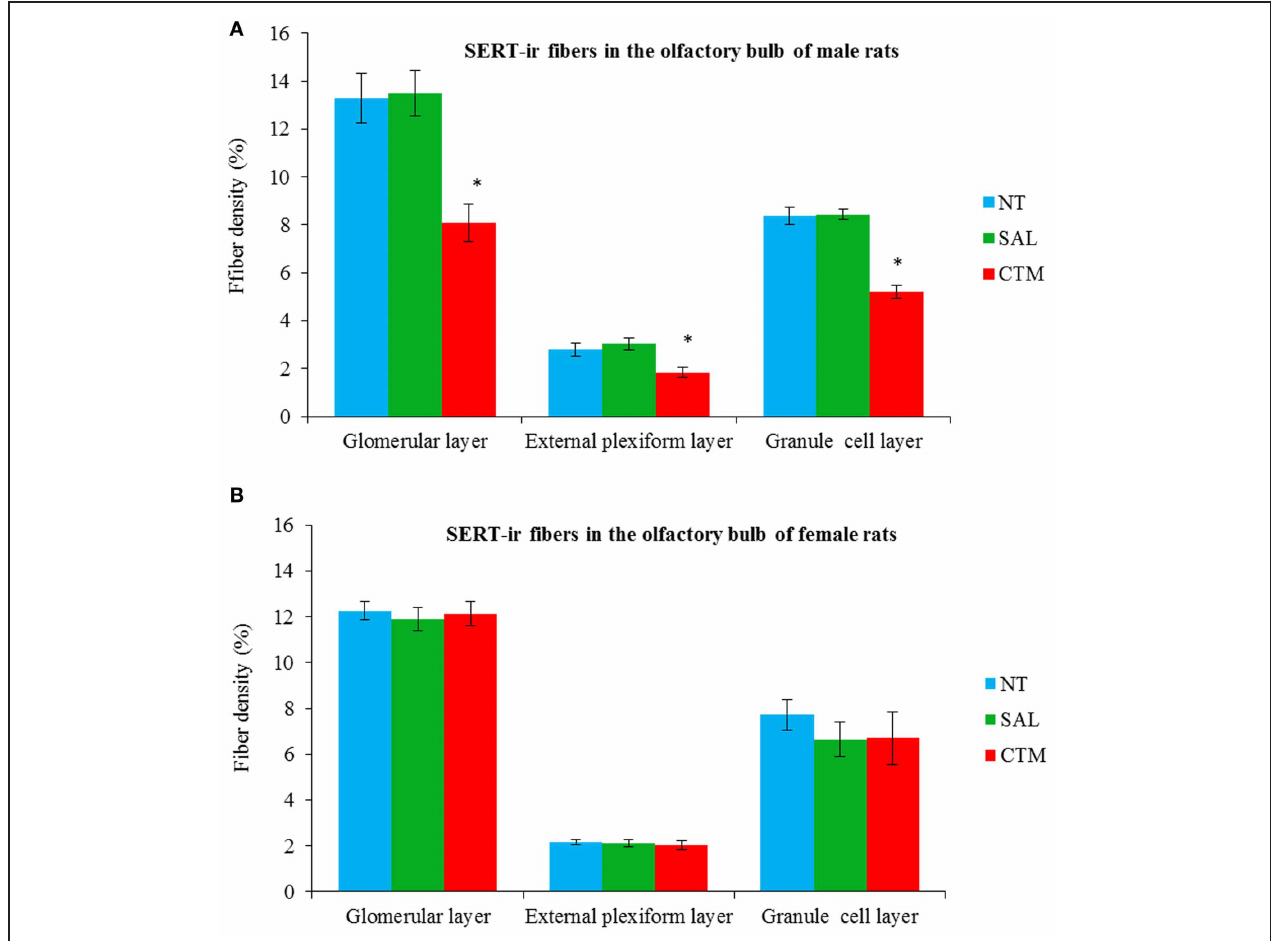
changes were not significantly different in female rats. Error bars = SEM. ∗ Represents p < 0 . 05 compared to SAL group. NT, non-treatment;